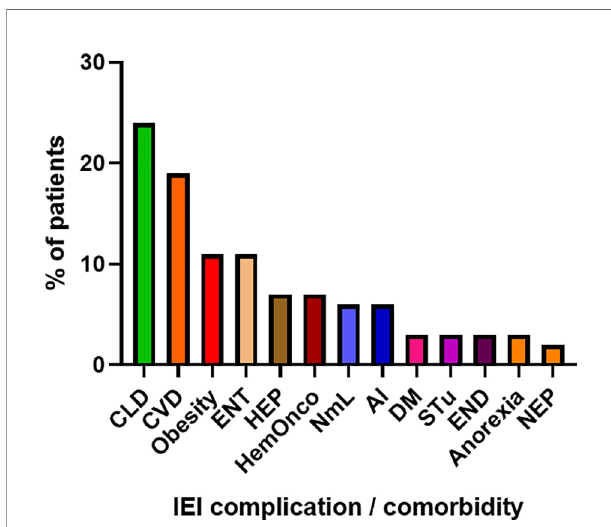
FIGURE 3 | Proportion of IEI (Inborn erorrs of immunity)-related complications and comorbidities in enrolled patients (n = 81). (CLD, chronic lung disease; CVD, cardiovascular disease; ENT, enteropathy; HEP, hepatopathy; HemOnco, hematologic malignancy; NmL, non-malignant lymphoproliferation; AI, autoimmunity; DM, diabetes mellitus; STu, solid tumor; END, endocrinopathy; NEP, nephropathy).